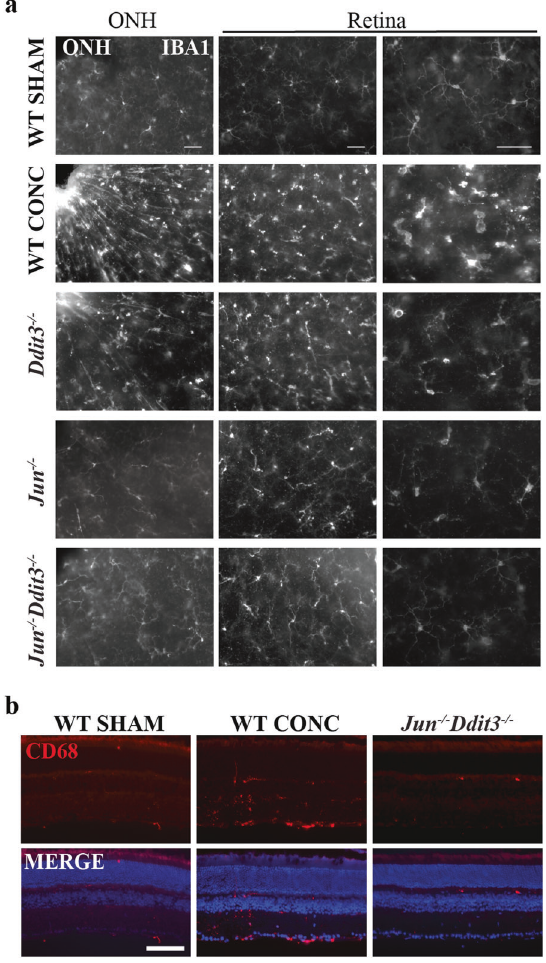
Fig. 6 Jun , Ddit3 , and Jun / Ddit3 de fi ciency attenuated myeloid cell responses after axonal injury. Whole-mount retinas were stained with IBA1 to label microglia/macrophages 7 days after CONC. As compared to WT sham retinas, IBA + immuno fl uorescence was greatly increased in WT retinas after CONC at both the optic nerve head (ONH) and peripheral retina. IBA + immuno fl uorescence was decreased in Ddit3 de fi cient animals and greatly diminished in Jun and dual Jun/Ddit3 de fi cient retinas ( a N ≥ 5 per genotype. Scale bars: 50 μ m) Retinal sections were also stained for CD68 and counterstained with DAPI 7 days after CONC. Increased CD68 + immuno fl uorescence was evident after CONC in WT retinas as compared to sham retinas, however, these changes were not observed in the dual Jun/Ddit3 de fi cient retinas after CONC ( b , N = 3 per genotype; Scale bar: 50 μ m). study of RGC extrinsic signaling changes that occur after axonal injury. We determined neuronal and proin fl ammatory signaling is signi fi cantly upregulated after axonal injury; Ddit3 , Jun , and Jun/Ddit3 de fi ciency attenuate differentially expressed genes after injury; and fi nally, proin fl ammatory changes after acute axonal injury in the retina are likely secondary to RGC apoptosis rather than a primary driver of retinal neurodegeneration. These results identify downstream networks of Jun and Ddit3 that may be broadly important for neurodegeneration.